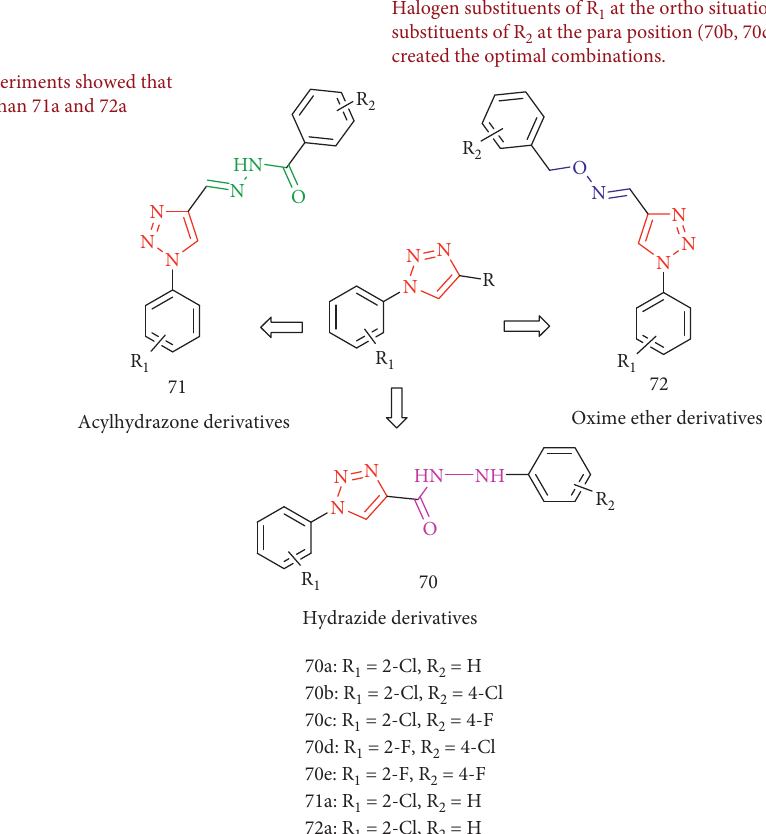
Figure 25: Chemical structure of 1,2,3-triazole hydrazide derivatives exhibiting antiphytopathogenic activity.